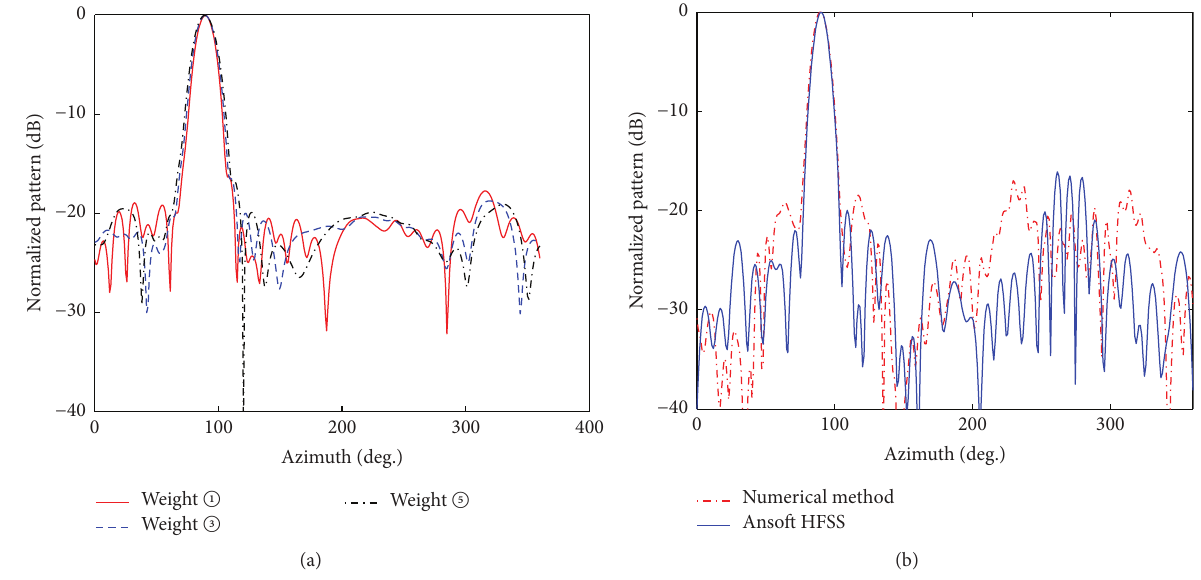
Figure 13: (a) Pattern synthesized by weight derived from weight A , weight C , and weight E in Table 4. (b) Comparison between Ansoft HFSS and numerical